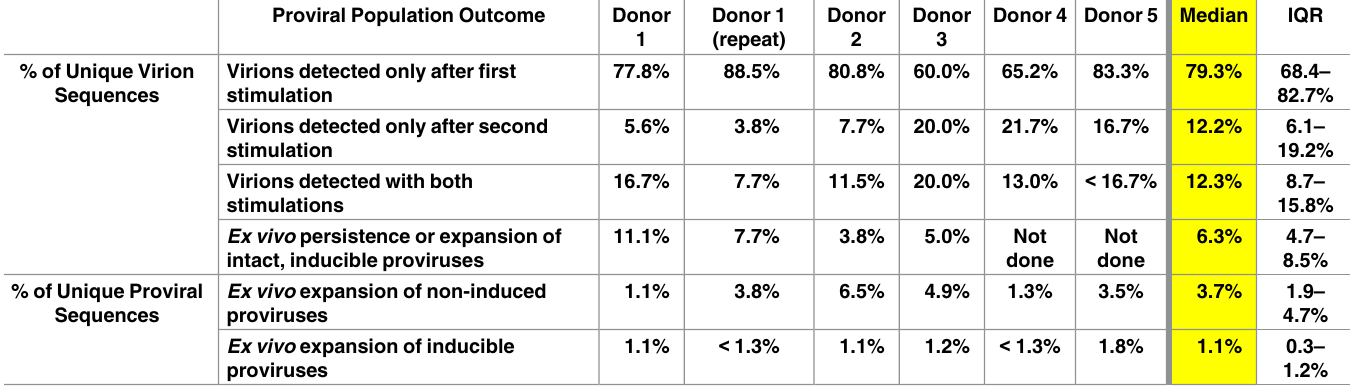
Table 2. Proviral expression and dynamics in total CD4 + T-cells after sequential stimulation. Different proviralpopulationoutcomes are quantified for experiments with total CD4 + T-cells. Each outcome is calculatedas either 1) the frequency of proviruses displayinga given outcome relative to the total num- ber of uniqueproviralsequencesobservedover the entire durationof cell culture, or 2) the frequency of uniquevirion sequencesdisplayinga given outcome relative to the total number of uniquevirion sequencesobservedover the entire durationof cell culture. IQR = interquartile range. Proviral Population